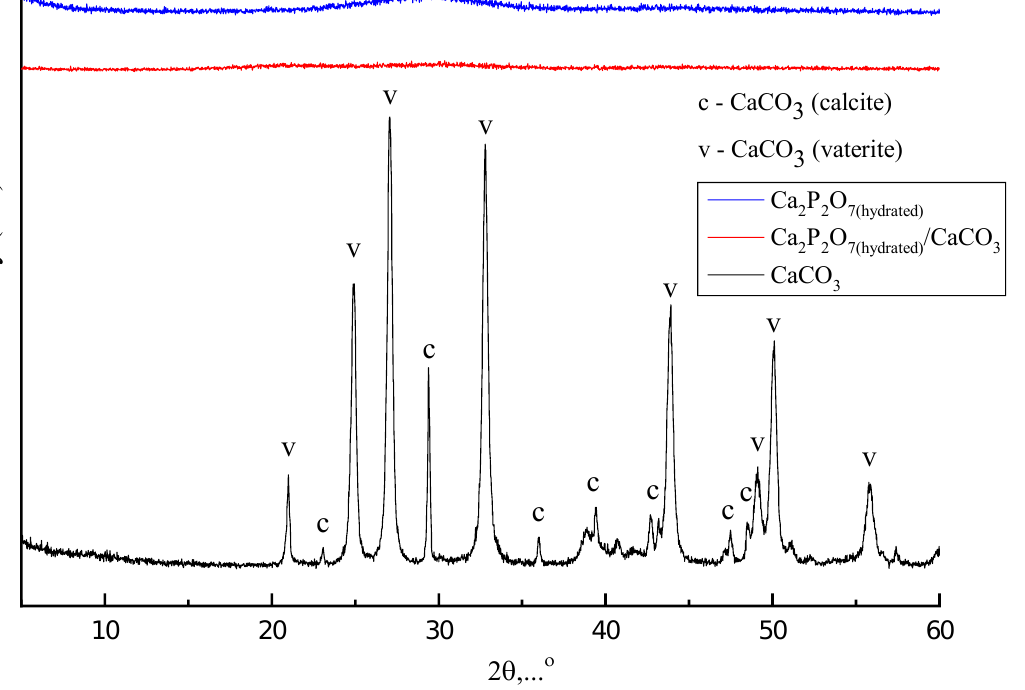
Figure 1. XRD data for powders synthesized from calcium acetate and ammonium pyrophosphate (blue diffractogram); calcium acetate and a mixed-anionic solution containing pyrophosphate and carbonate ions (red diffractogram); calcium acetate and ammonium carbonate (black diffractogram).